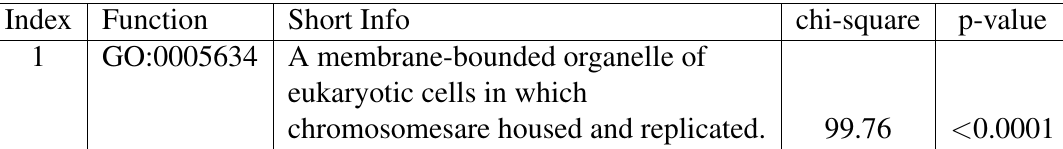
Table 5: Most discriminative function from Cellular Component based on FS